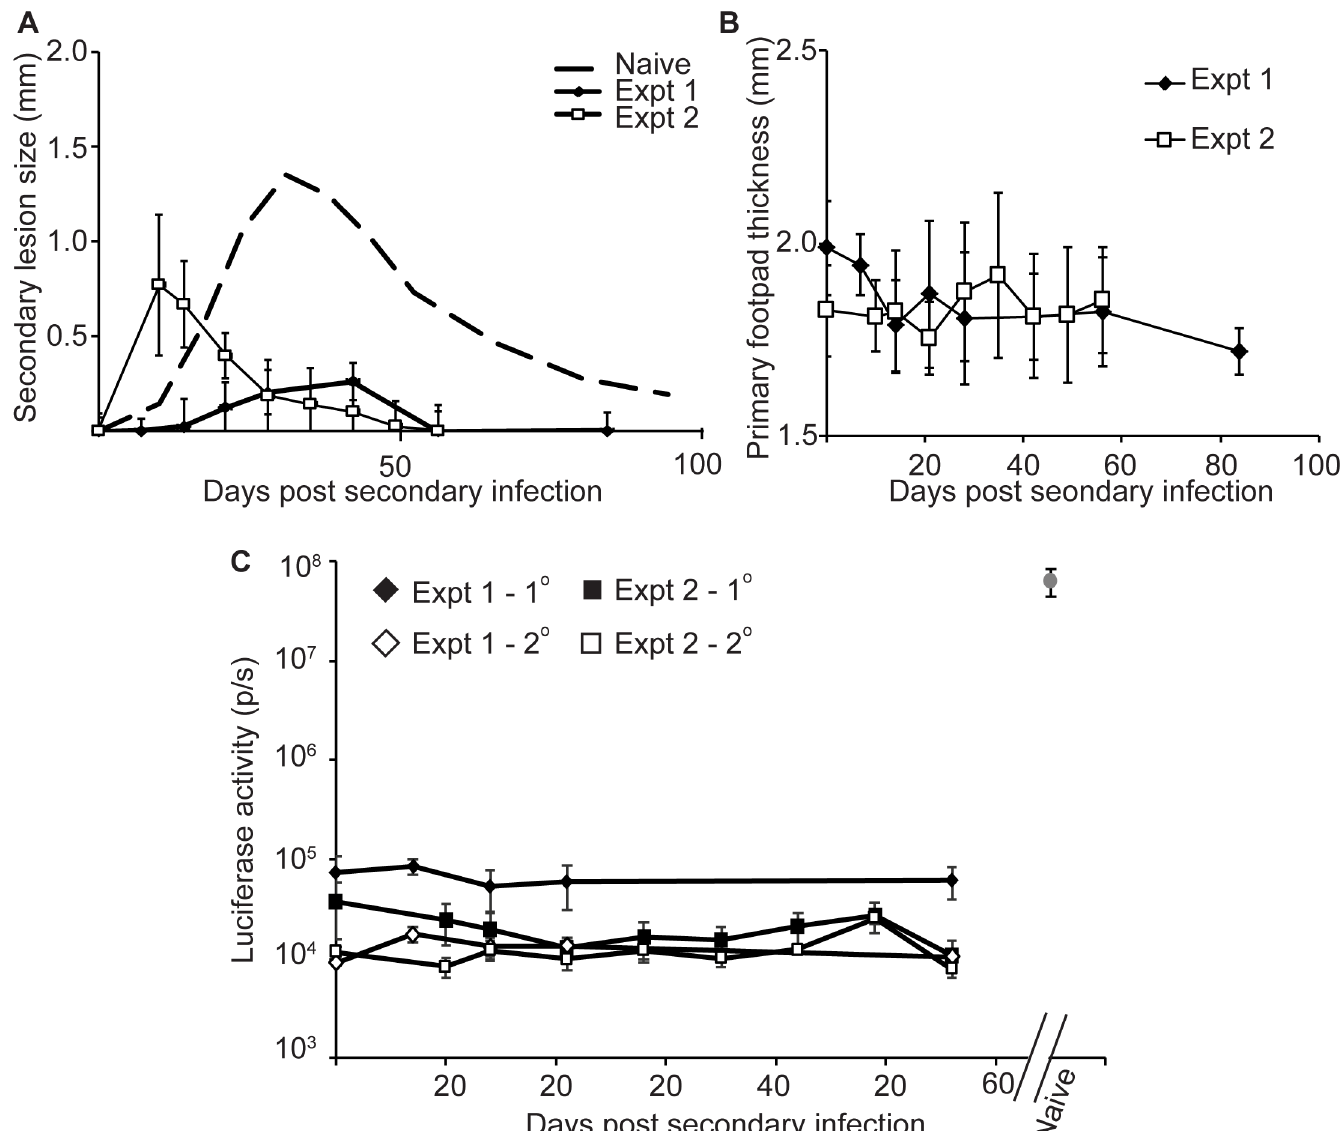
Fig 2. Mice persistently infected with LmjF-LUC-SAT show protection from disease pathology by secondary challenge with LmjF-PHLEO parasites. Mice (4-5/group) were inoculated with 10 5 metacyclic LmjF-LUC-SAT parasites in the left hind footpad (primary site), after which they developed lesions and then went on to heal (similar to that shown in Fig 1A). (A) At least one month after resolution of the primary lesions, each mouse was inoculated in the right hind footpad (secondary site) with 10 5 metacyclic LmjF-PHLEO parasites, and lesion progression is shown in the figure. The dashed line represents the average of the data presented in Fig 1A for infections of na ï ve mice with LmjF LUC-SAT and LmjF-PHLEO for comparison. In these experiments “ time 0 ” is when the secondary inoculation was performed unless otherwise indicated. For all plots, error bars show the standard deviation (n = 4 or 5 in expt. 1 or 2 respectively). (B) Footpad thickness at the primary injection site (left foot). (C) Monitoring of reactivation of the primary LmjF-LUC-SAT parasites at the primary ( ♦ , ■ ) or secondary ( ^ , □ ) infection sites site by bioluminescent imaging of luciferase expression in vivo ; experiment 1 ( ♦ , ^ ); experiment 2 ( ■ , □ ). The gray circle (upper right) shows the luminescence profile of LmjF-LUC-SAT parasites infecting na ï ve mice at the peak of infection, included for comparison only. Error bars depict the standard deviation.